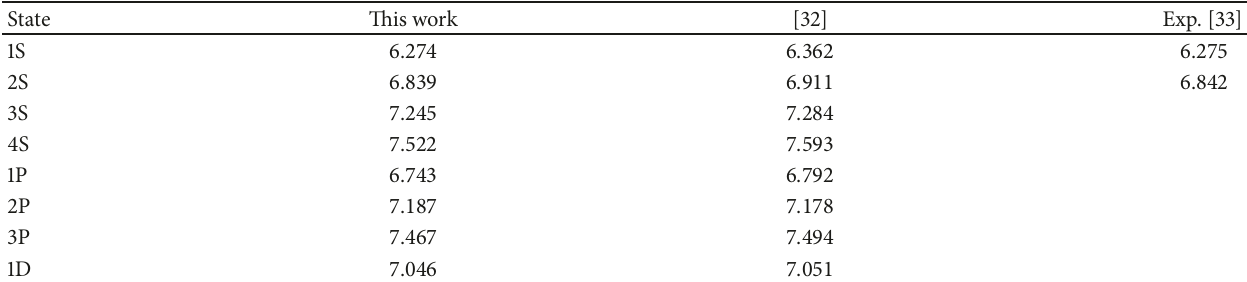
Table 10: Bottom-Charmed spectra. All results are in